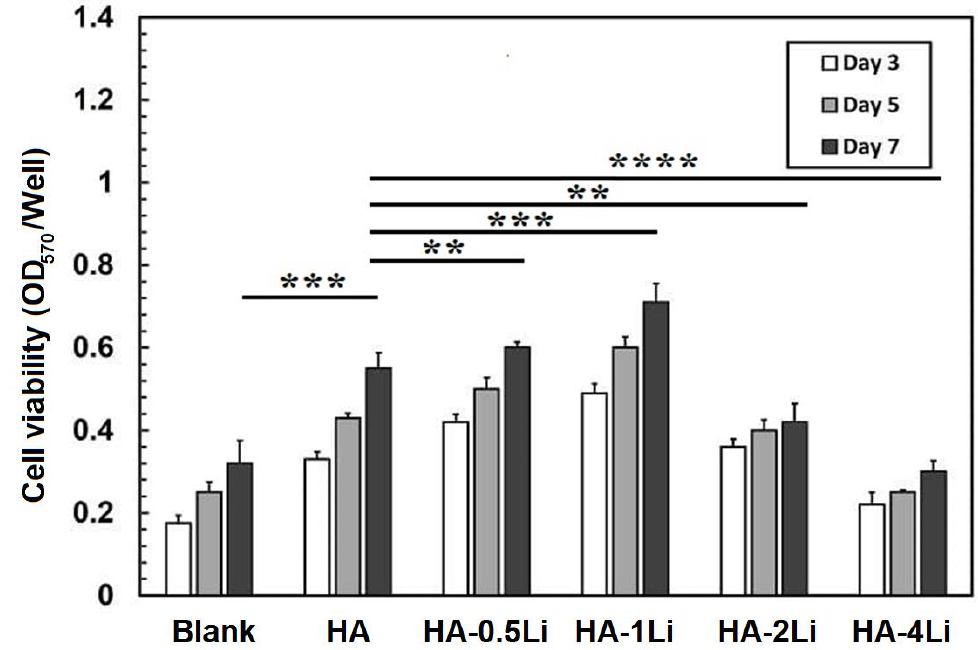
Figure 7. Optical density of cell seeded on: ( a ) HA. ( b ) HA-0.5Li. ( c ) HA-1Li. ( d ) HA-2Li. ( e ) HA-4Li. (** for p < 0.01; *** for p < 0.001 and **** for p < 0.0001).